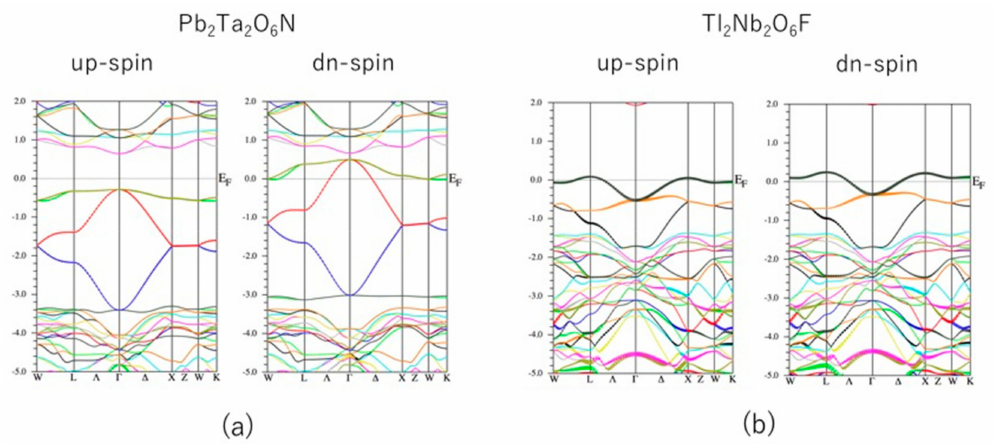
Figure 3. Spin-dependent band structure of ( a ) Pb 2 Ta 2 O 6 N and ( b ) Tl 2 Nb 2 O 6 F. The unit of the vertical axis is